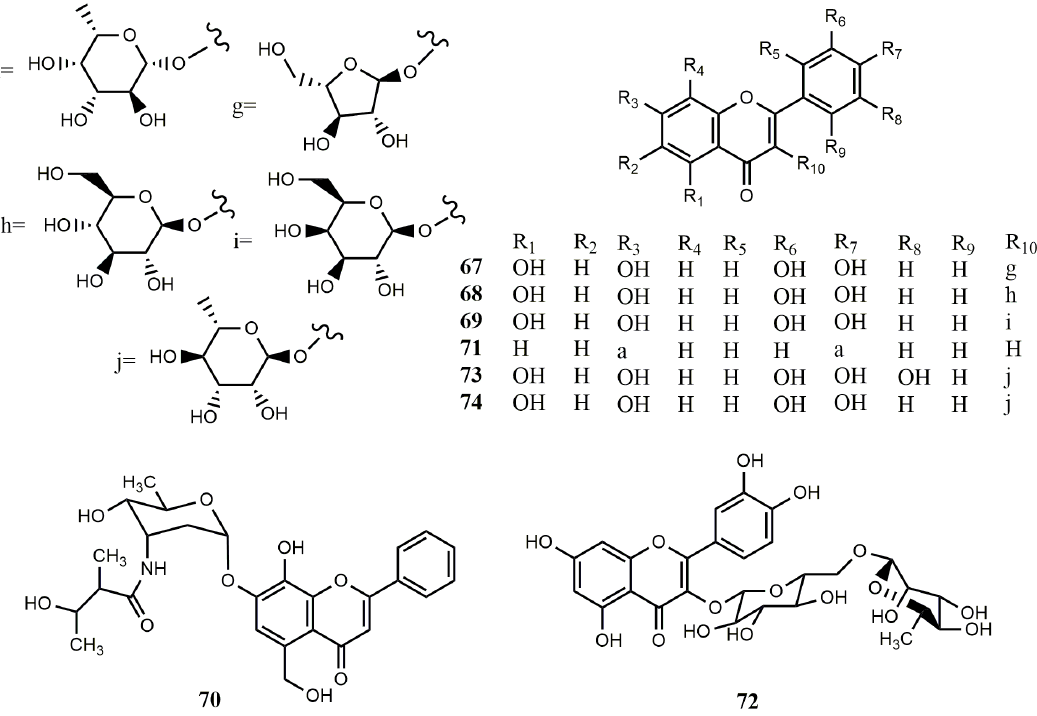
Figure 5. Reported structures of flavonoid glycosides 67 – 74 from fungi and actinomycetes.